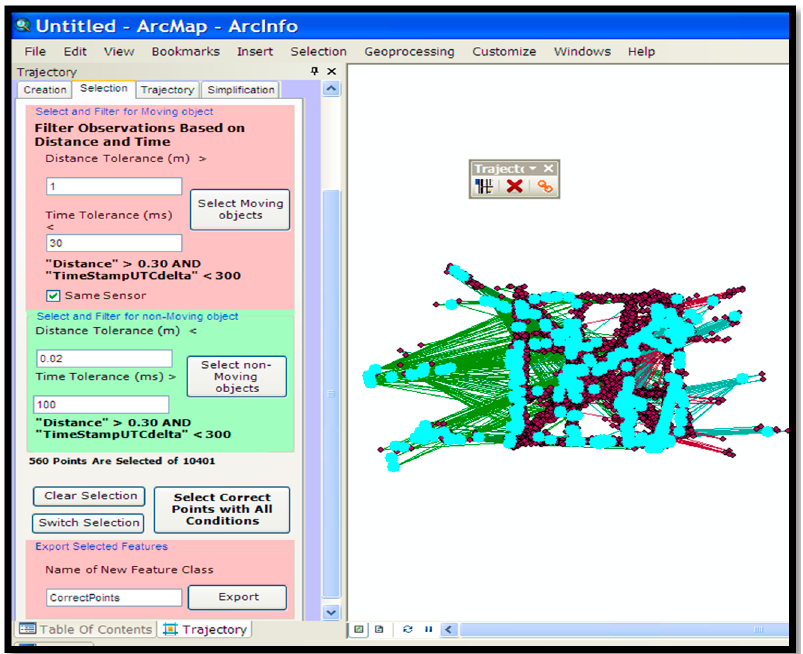
Figure 7. Noise/error filtering and stay point detection tab.